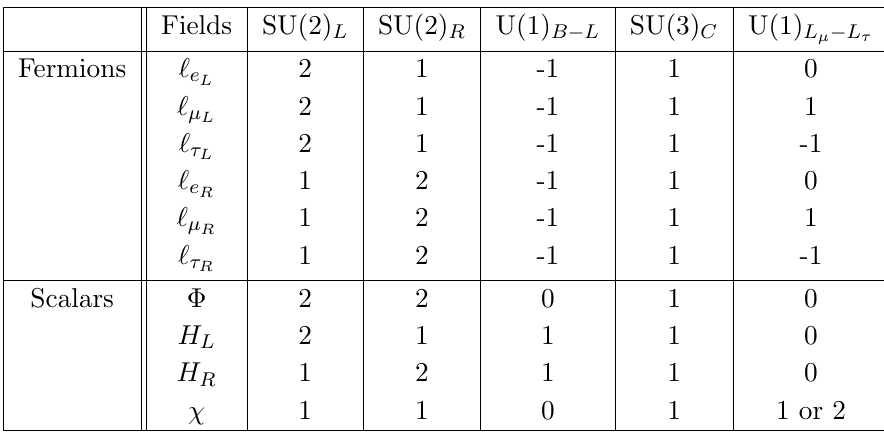
Table 2 . Particle content of left-right theories extended with U(1) L fermion sector is limited to leptons and scalar sector contains the bidoublet (cid:8), doublets H L;R and a singlet (cid:31)